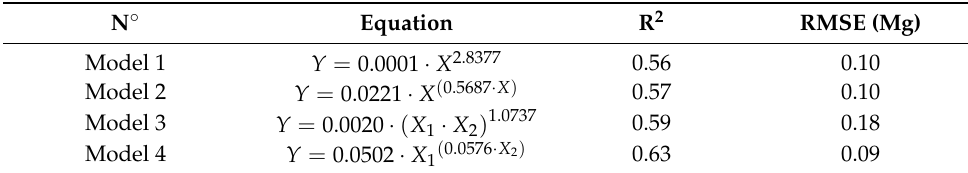
Figure 7. Tree crown segmentation areas (colored in green) identified within cutting polygons (in white) indicated by the CB6. Red area represents GDC study sites. Table 4. Equations and R 2 of the four adopted regression